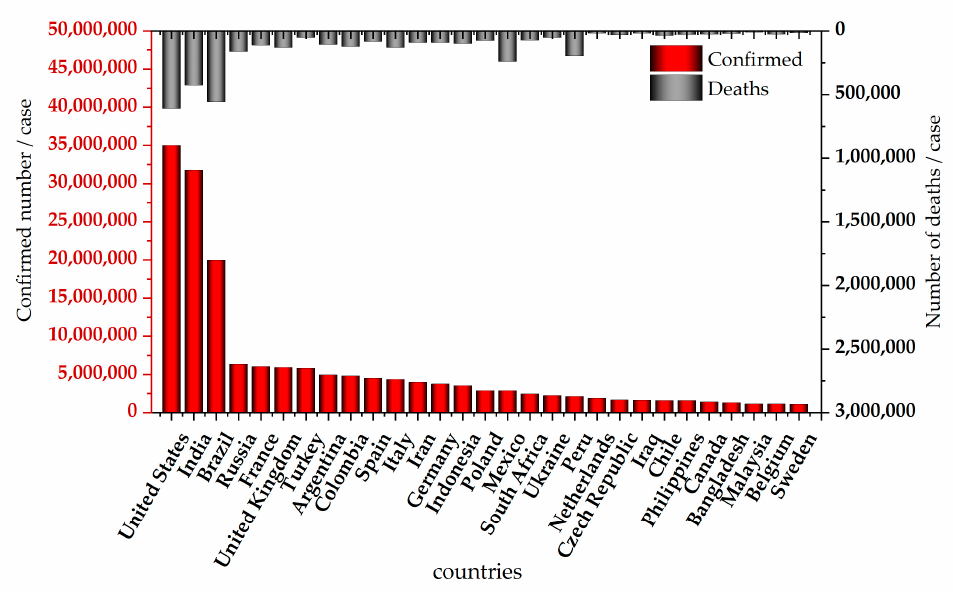
Figure 1. The number of confirmed cases and deaths cases. X-ray images (X-ray) and computed tomography images (CT) have become an im- portant tool for the detection of COVID-19. The images of COVID-19 contain ground-glass opacities (GGOs), areas of consolidation and a mix of both in all lung lobes [3]. Figure 2 shows the X-ray and CT images of COVID-19, pneumonia and normal lungs.